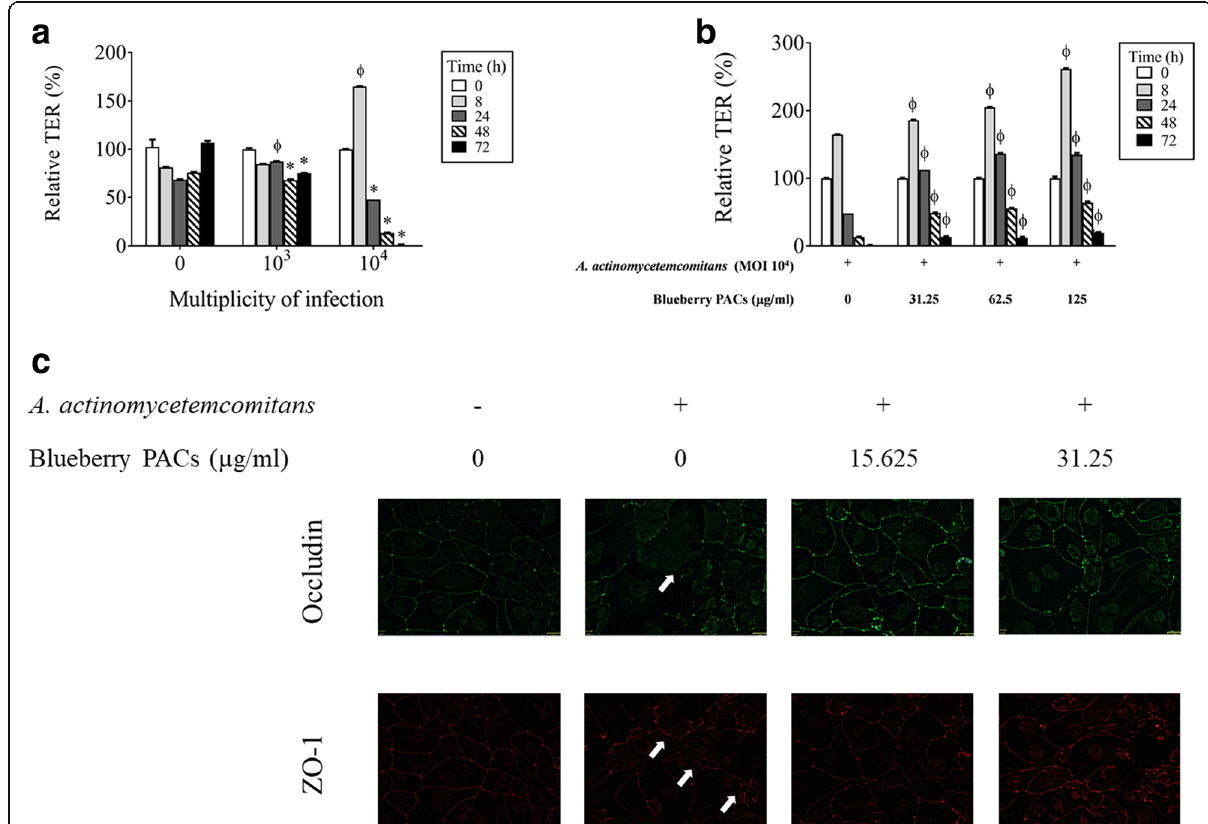
Fig. 4 Effect of A. actinomycetemcomitans in the absence and presence of highbush blueberry PACs on the integrity of the oral keratinocyte tight junction. Panel a : Effects of time and the number of A. actinomycetemcomitans cells on the transepithelial electrical resistance (TER) of oral keratinocytes. Panel b : Inhibitory effect of highbush blueberry PACs on the A. actinomycetemcomitans -induced decrease in the TER of oral keratinocytes. Panel c : Immunofluorescence staining of tight junction proteins occludin and zonula occludens-1 (ZO-1) of oral keratinocytes infected (24 h) by A. actinomycetemcomitans in the absence and presence of blueberry PACs. A 100% value was assigned to the TER at time 0. Results are expressed as the mean ± SD of triplicate assays. Φ : significant increase ( p < 0.001) compared with unstimulated control cells ( a ) or with A. actinomycetemcomitans -stimulated cells not treated with highbush blueberry PACs (B). ∗ : significant decrease ( p < 0.001) compared with unstimulated control